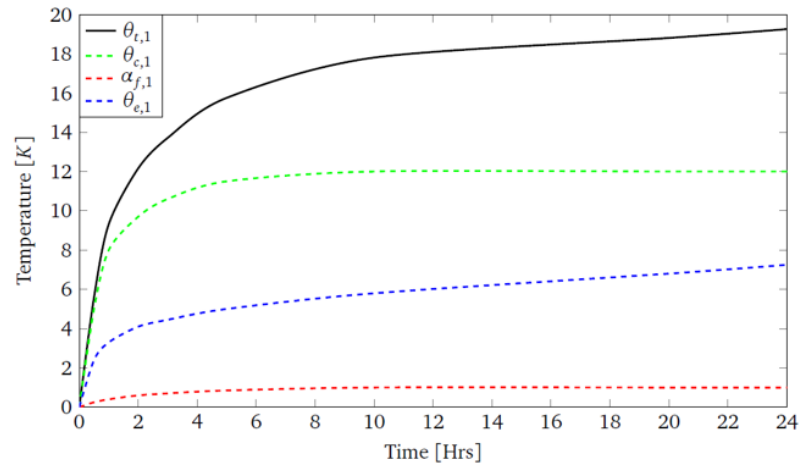
Figure 16. Total transient temperature response of a single load step given by Equation (50).